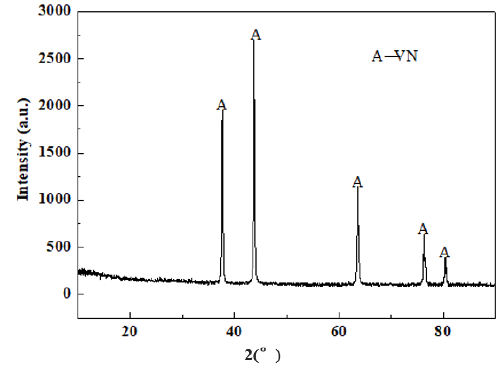
Figure 7. Phase analysis of VN alloys.